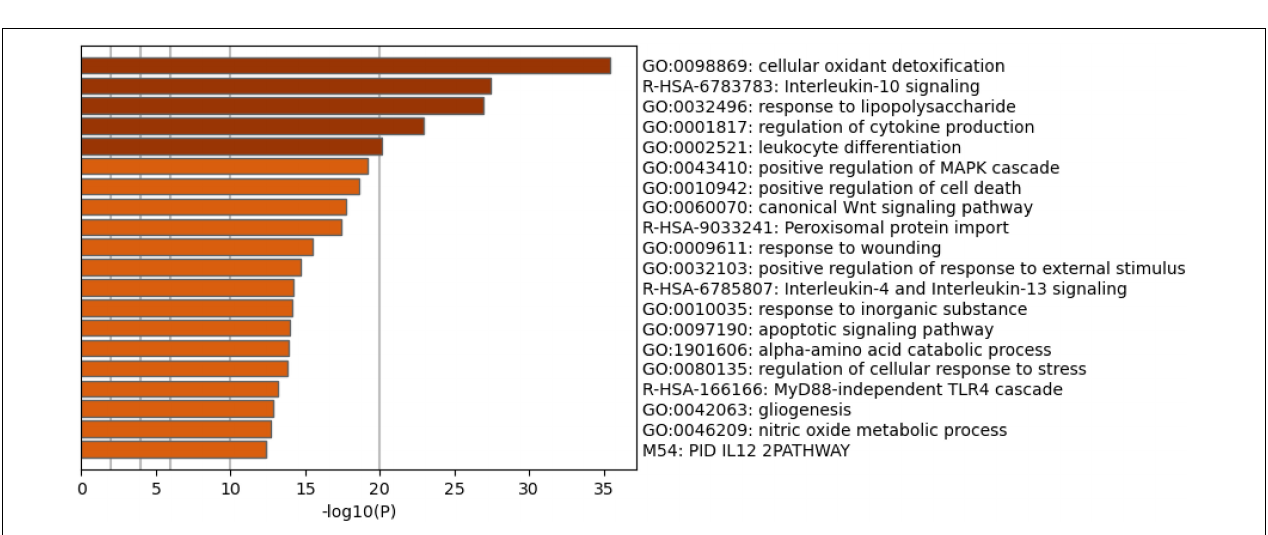
FIGURE 4 | Heatmap of enriched ontology clusters showing the top 20 functions that were overexpressed in the network of patients with chronic fatigue spectrum disorders (accumulative hypergeometric p